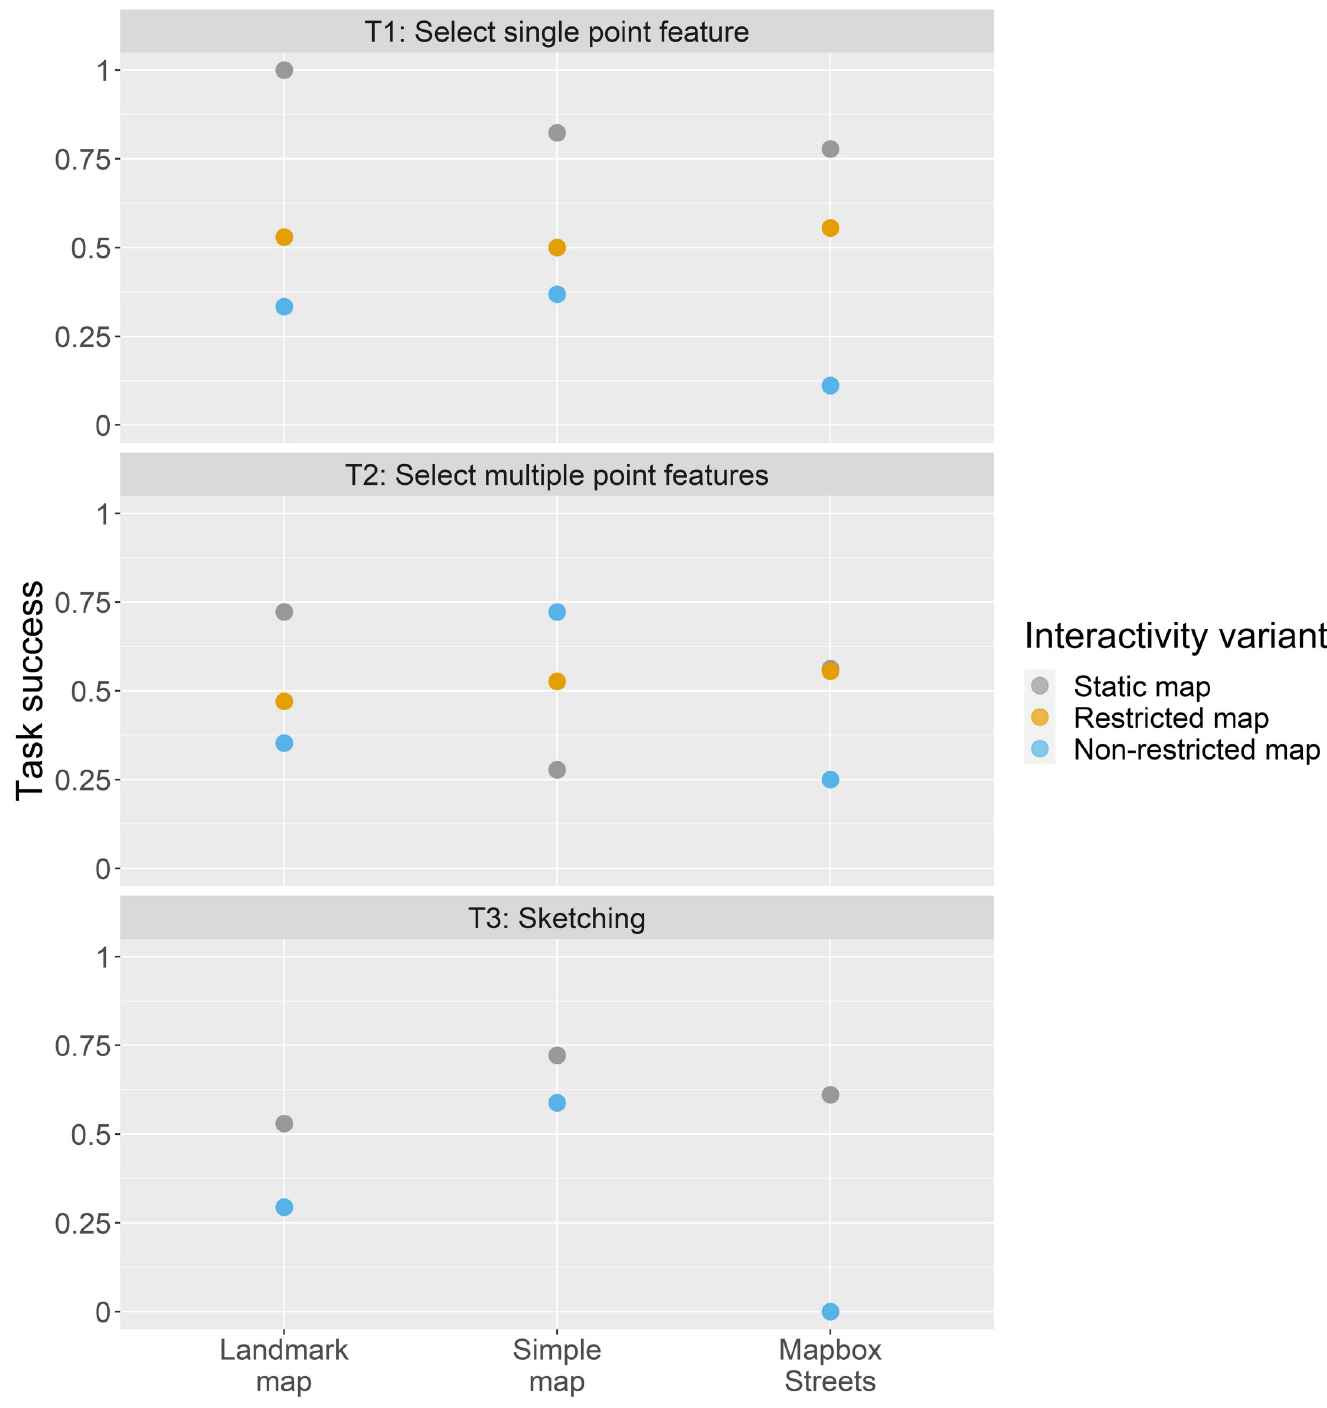
Fig 4. Task success of map-reading tasks related to base map styles and interactivity variants.